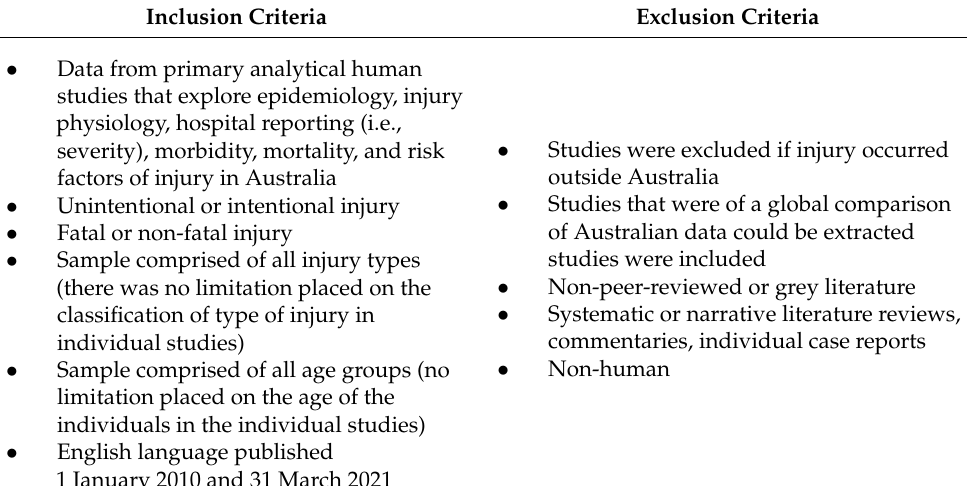
Table 1. Inclusion and Exclusion